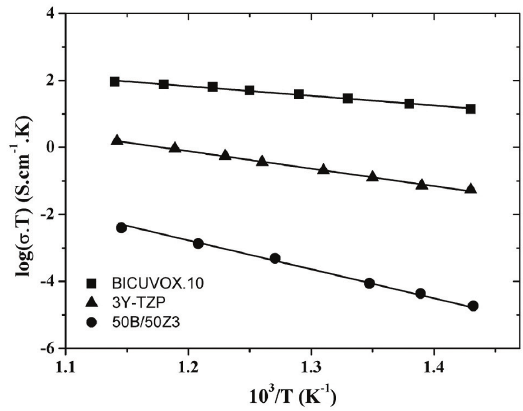
Figure 5. Arrhenius plot for BICUVOX.10, 3Y-TZP and 50B/50Z3, indicating the effects of reactions and phase transformations in the electrical conductivity.